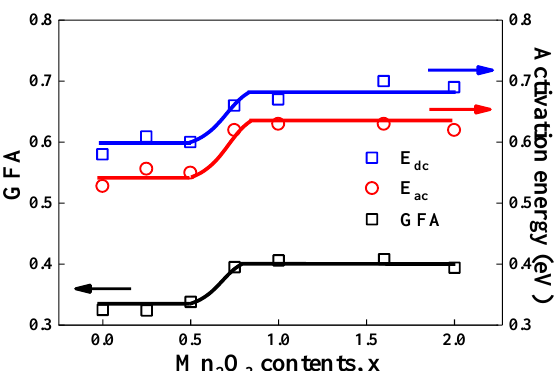
Figure 6. Composition dependence of GFA = T c /(T g + T m ) and dc- and ac-activation energies, 𝐸 𝑑𝑐𝐽 E J ac , for 3Li 2 O-(2-x)Fe 2 O 3 –xMn 2 O 3 -3P 2 O 5 (0 ≤ x ≤ 2.0) glasses. The curves are guides for the eyes. and E acJ , for 3Li 2 O-(2-x)Fe 2 O 3 – xMn 2 O 3 -3P 2 O 5 ( 0 ≤ x ≤ 2.0 ) glasses. The curves are guides for the eyes.